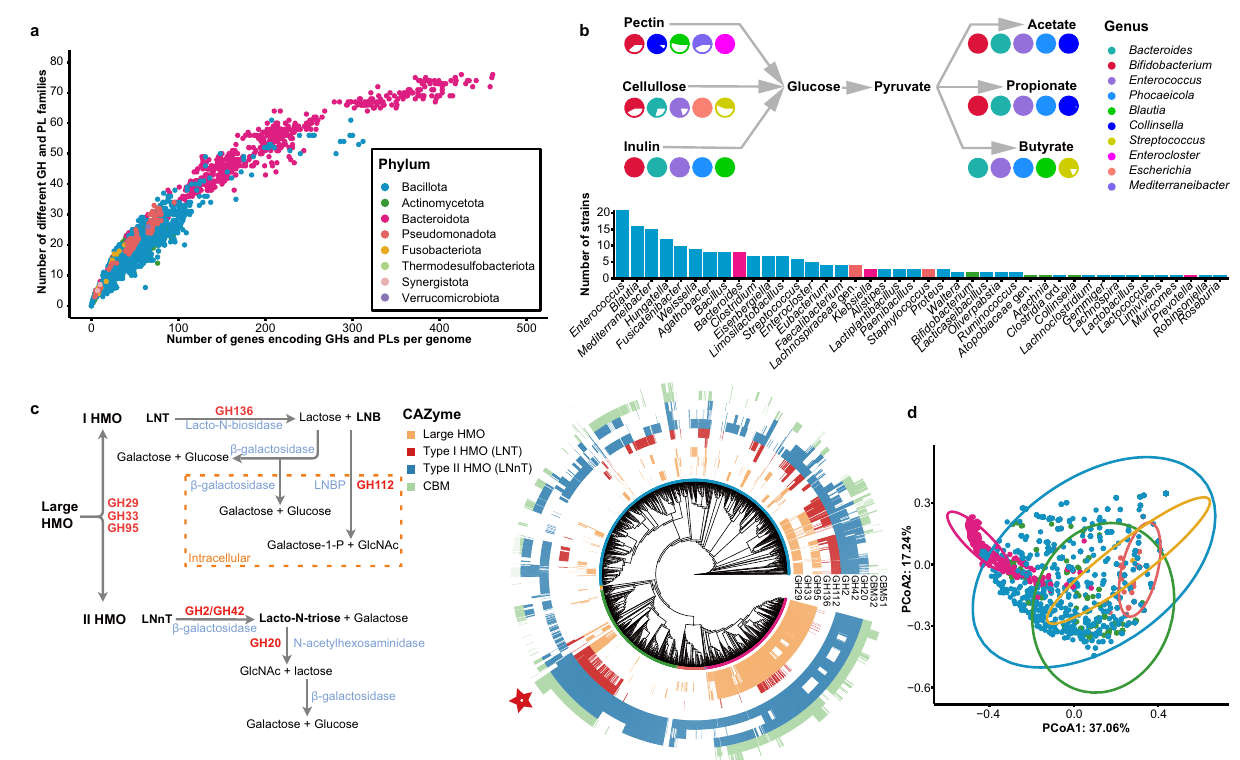
Fig. 2 | Distribution of CAZymes in the CGR2 genomes. a Differences in the numbers of genes encoding GH and PL, and the numbers of GH and PL families representedinthesegenomes. b Simpli fi edillustrationshowingthedegradationof dietary fi bers and the synthesisof SCFAsby the dominant genera (see “ Methods ” ). Ratio of the numbers of strains in top fi ve genera with complete pathways and in genera of CGR2 is shown as pie plot charts (see Supplementary Data 6). Phylum annotation of bar chart as in ( a ). c Simpli fi ed schematics of pathways involved